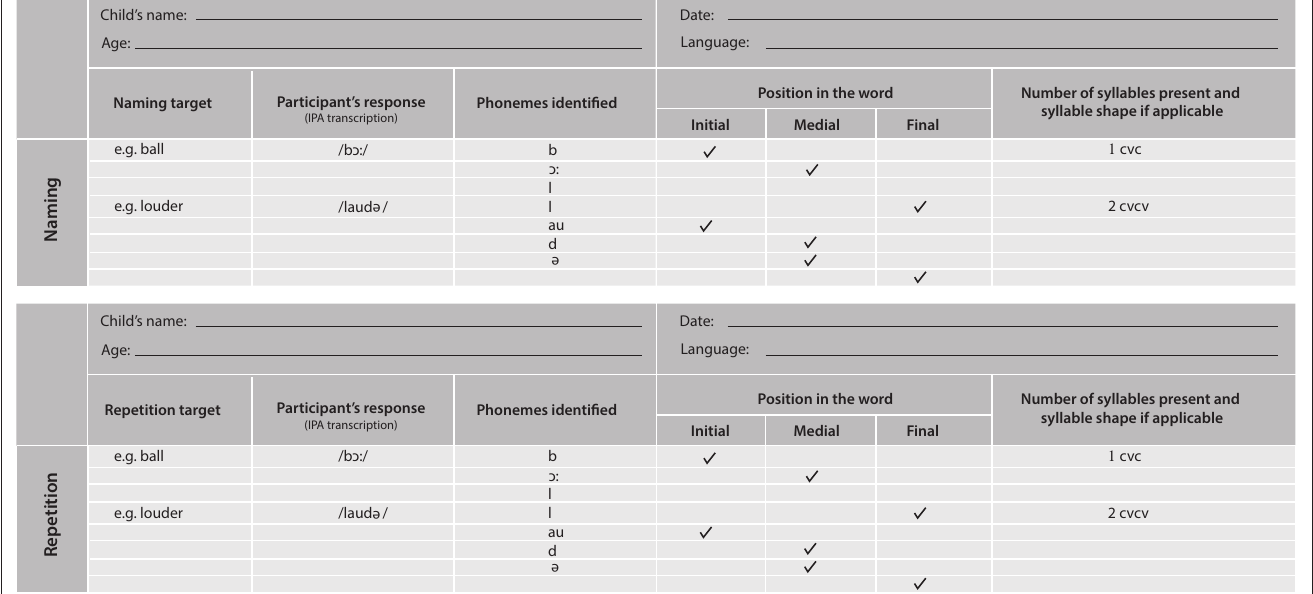
PCC PVC/PVC Manner of articulation: e.g. plosive s